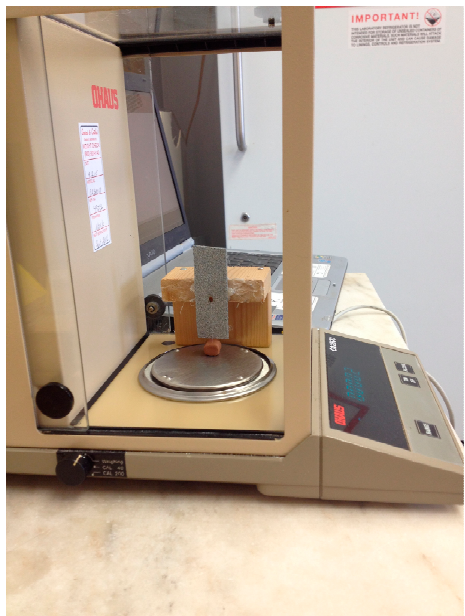
Figure 1. Photograph of a pulling force assay on an analytical balance. Here, a bed bug is pictured gripping the rough sandpaper surface on the wooden platform.